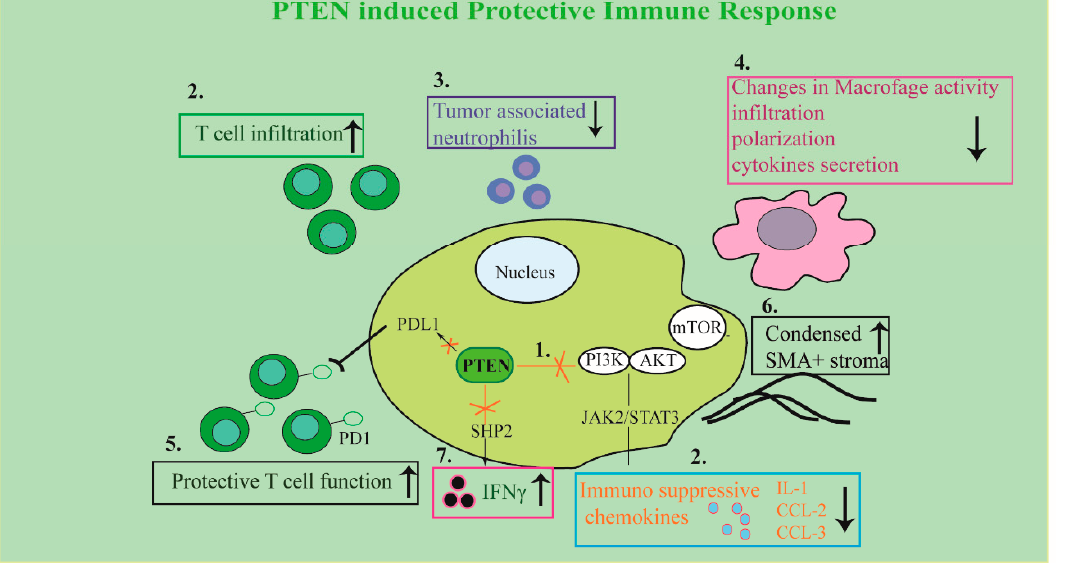
Figure 3. A schematic summary illustrating PTEN role in tumor/stroma interplay. See the text